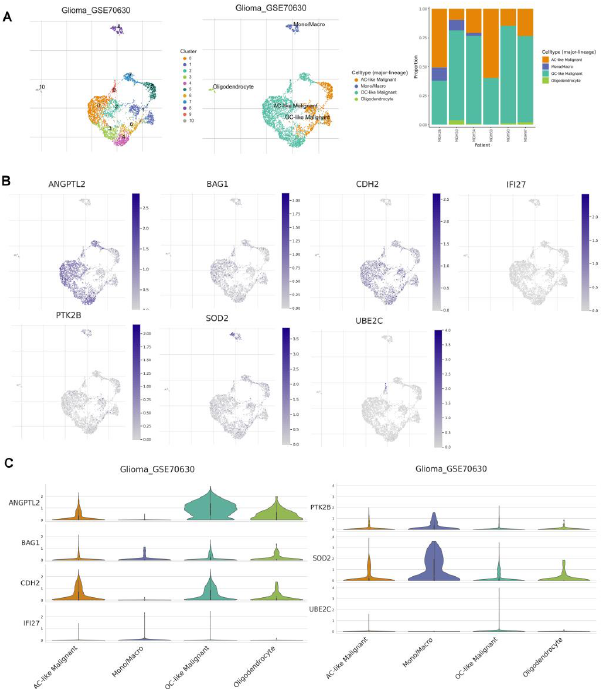
Figure 11. 7ANRGs in single-cell RNA sequencing ( A ) Annotation of all cell types in GSE70630 and the percentage of each cell type. ( B , C ) Expression of ANGPTL2, BAG1, CDH2, IFI27, PTK2B, SOD2, and UBE2C in each cell type.